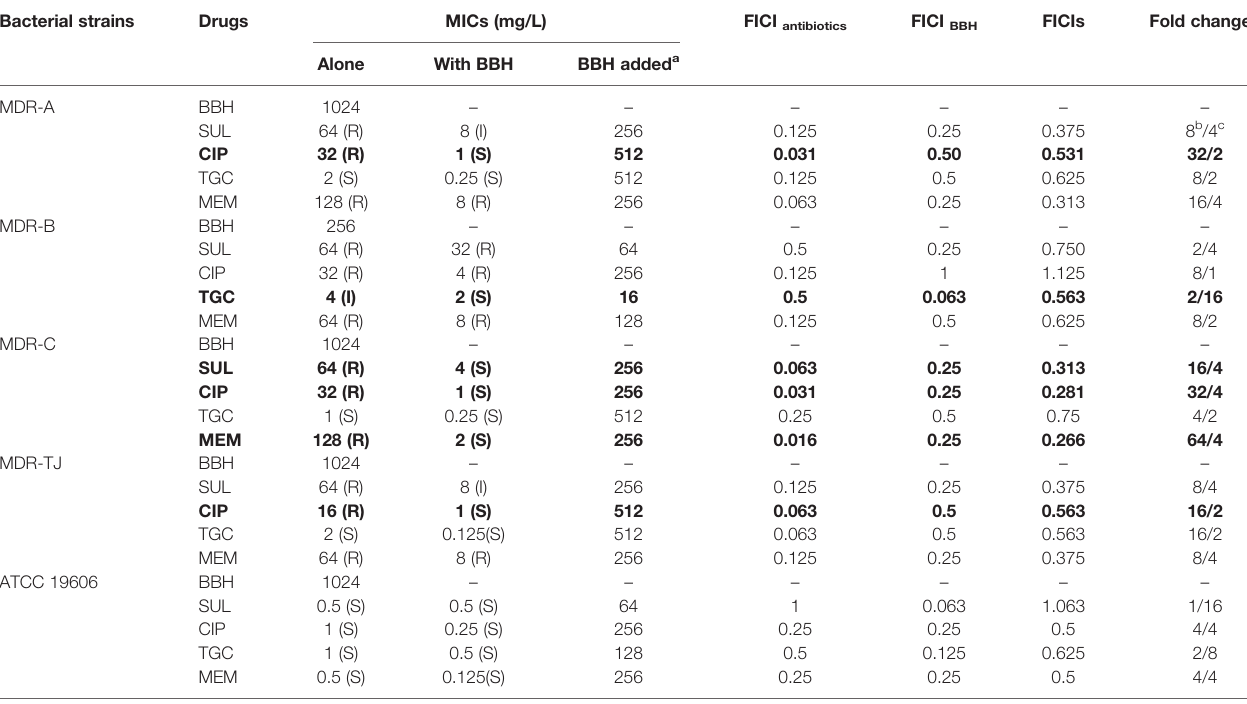
TABLE 1 | MICs pro fi le and interactions between BBH and antibiotics. Bacterial